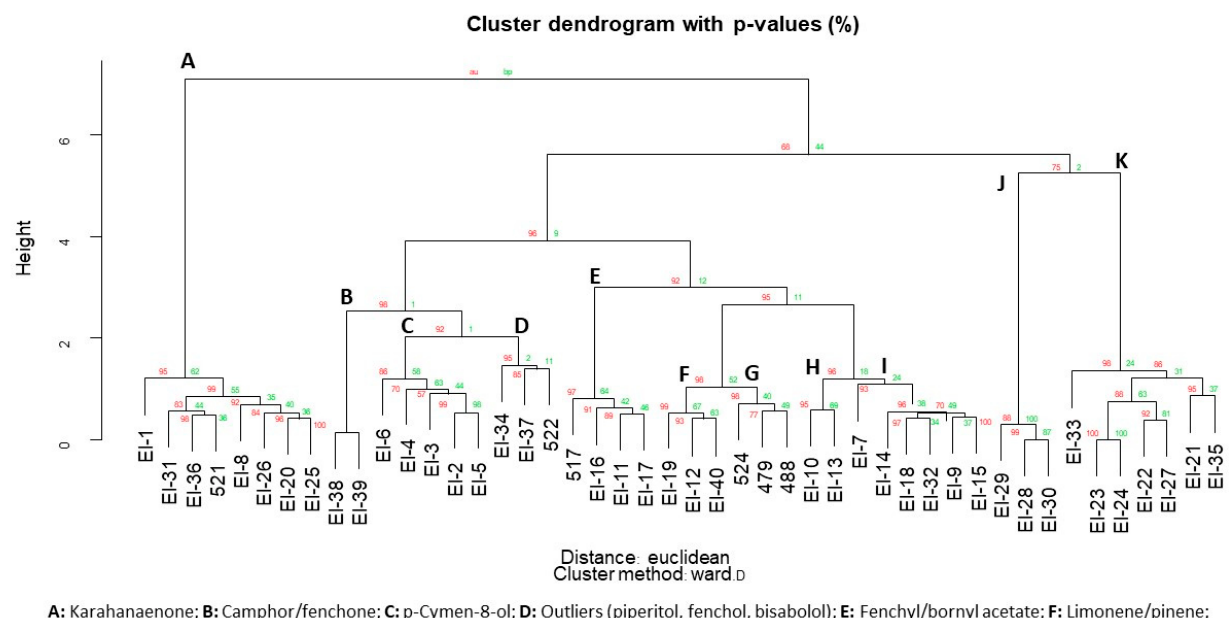
Figure 6. Dendrogram of essential oil components from Eremophila longfilia using data from the current study and a previous study.